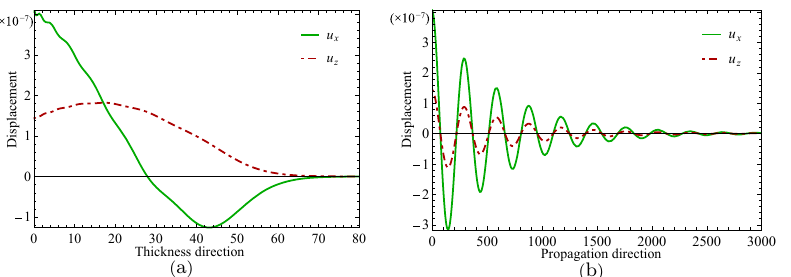
Figure 10. Displacement distributions for thickness direction in ( a ) and propagation direction in ( b ) when f = 24.07 Hz, ξ = 2.1365 + 0.1694 i .